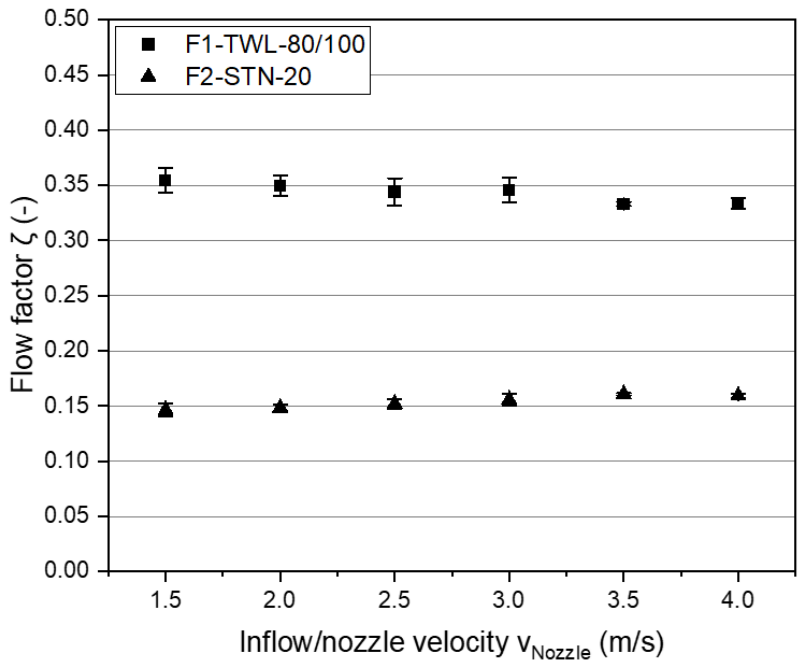
Figure 4. Backflow factor ζ BF of a defined water volume streaming through filter cloths. Confidence intervals with α = 0.05.